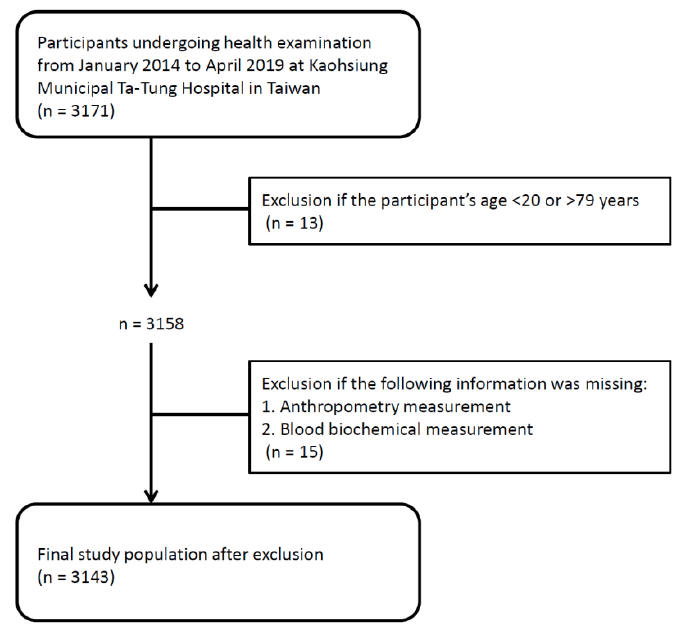
Figure 1. Study population and flowchart.